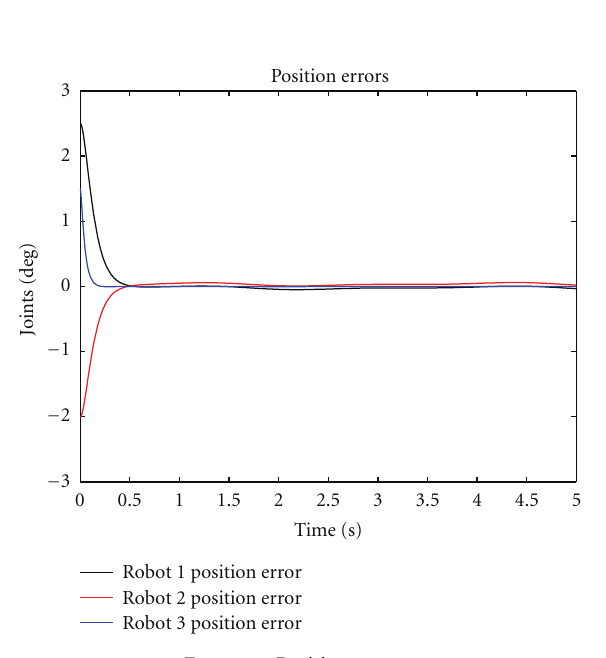
Figure 5: Position